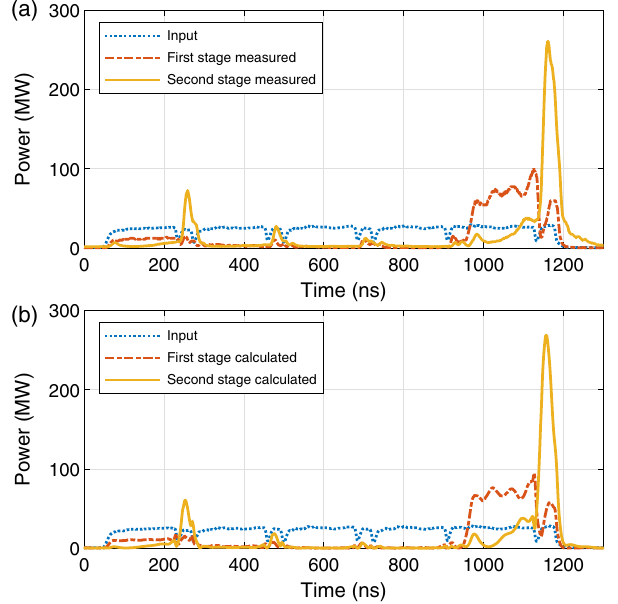
FIG. 15. Waveforms of the two-stage pulse compression high- power test. (a) Measured waveforms of the input, first-stage output, and second-stage output. (b) Measured waveforms of the input and calculated waveforms of the first- and second-stage